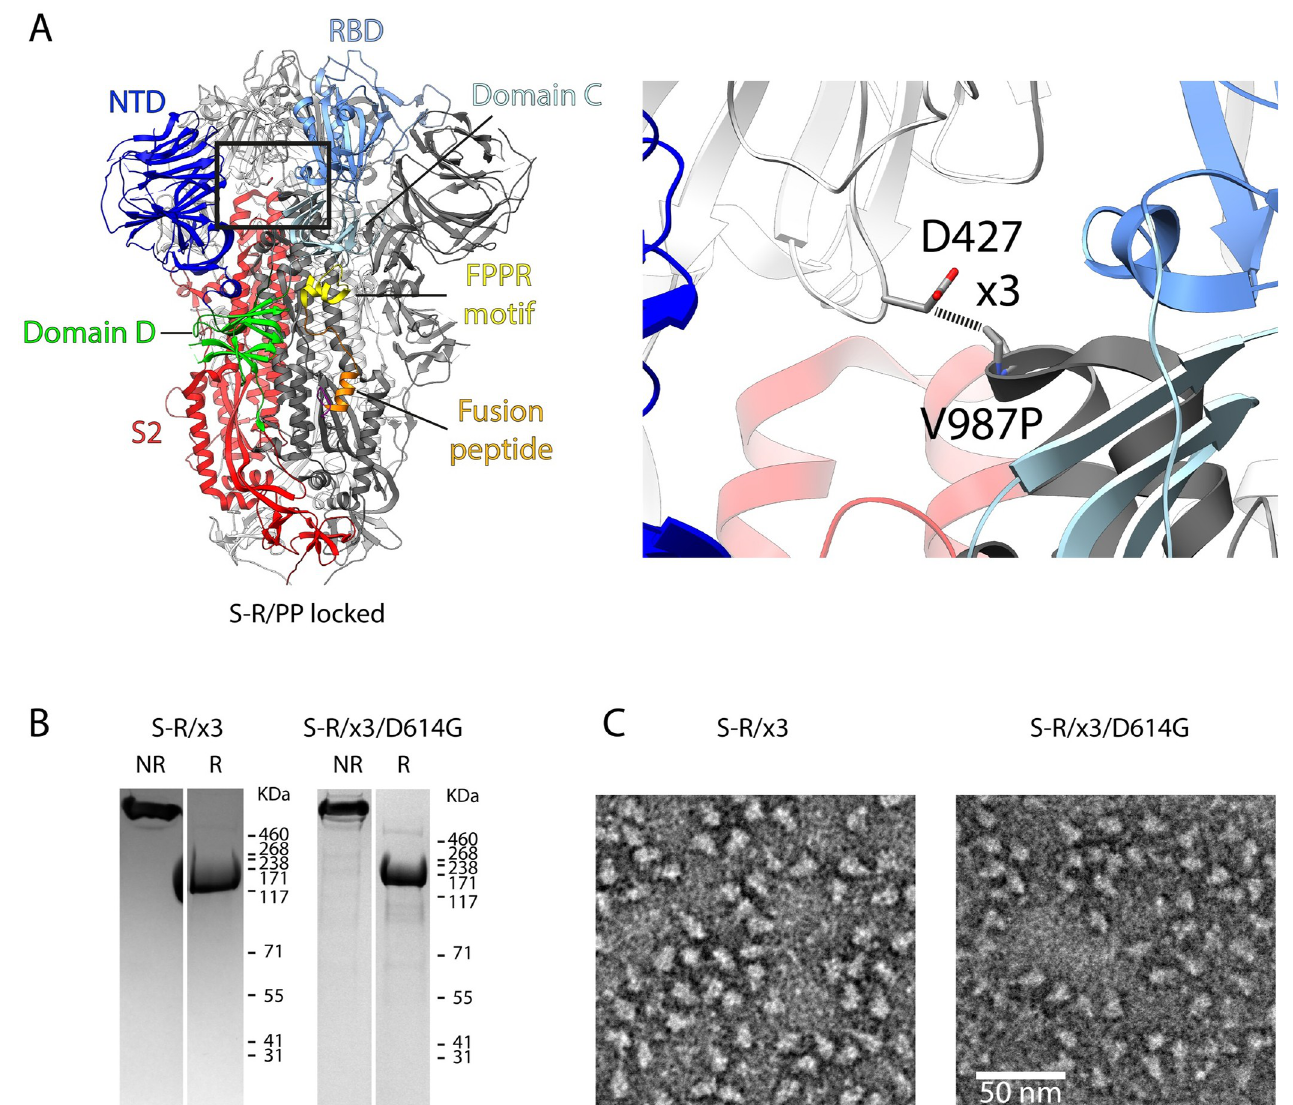
Fig 1. Design of the x3 disulfide bond to stabilise the SARS-CoV-2 spike in the “locked” state. (A) Structure of the S-R/PP spike in the locked state (PDB: 6ZP2). Structural domains are coloured and labelled. The box indicates the location of the zoomed-in view in the right panel. Residues 427 and 987 that were mutated to cysteine to form the x3 disulfide bond are indicated. (B) Coomassie-stained SDS-PAGE gels to assess expression of the S-R/x3 and S-R/x3/D614G S proteins and confirm formation of a disulphide bond. NR or R indicates protein samples were prepared in non-reducing or reducing conditions. (C) Negative stain EM images of the purified S-R/x3 and S-R/x3/D614G spikes.